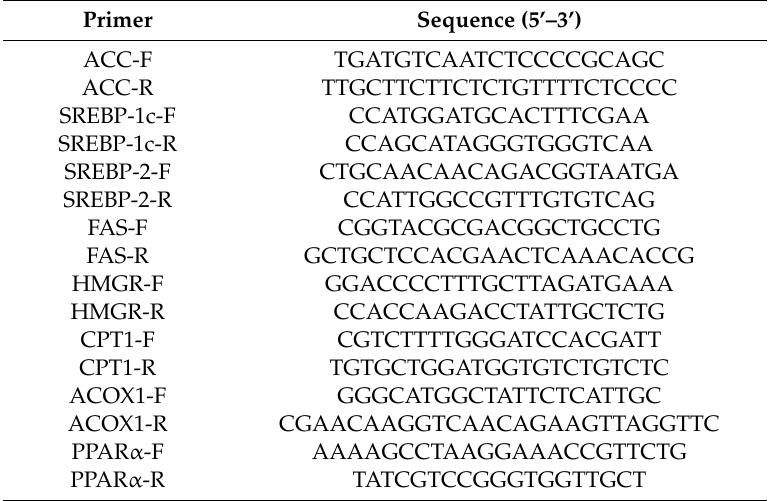
Table 1. The primer sequences of gene